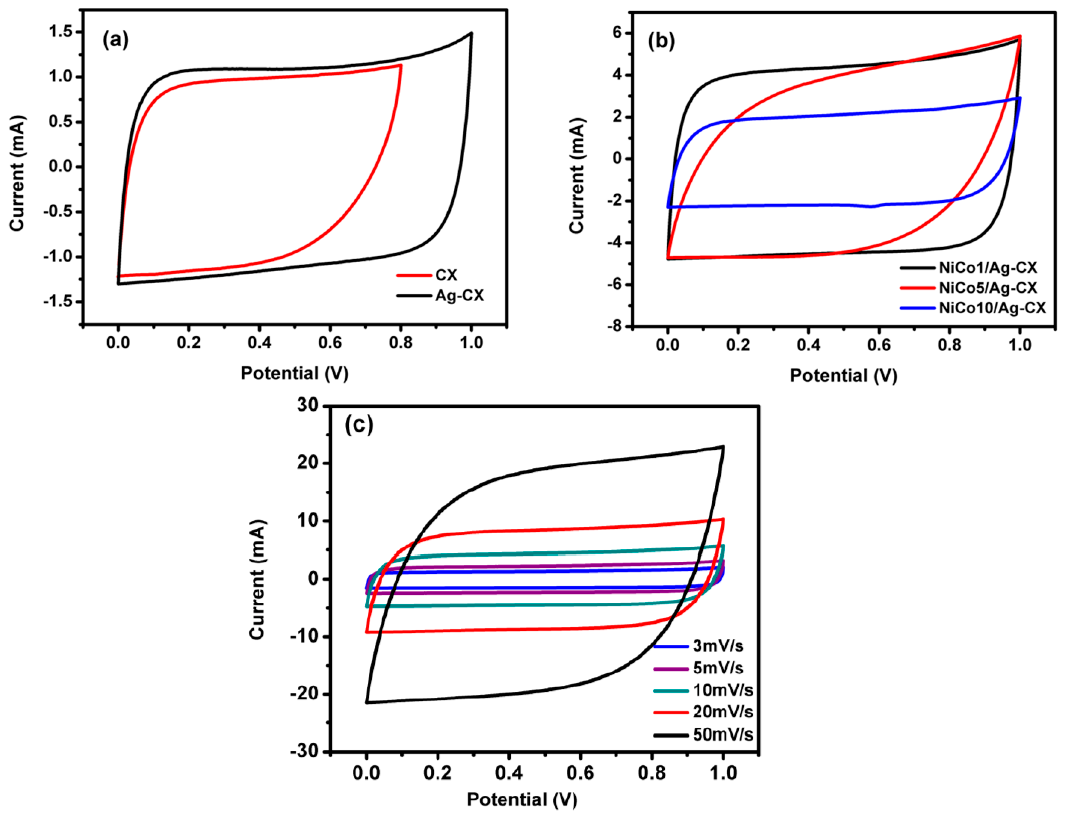
Figure 5. CV curves for ( a ) CX and Ag-CX at 5 mV ∙ s − 1 , ( b ) NiCo1/Ag-CX, NiCo5/Ag-CX, and NiCo10/Ag-CX at 10 mV ∙ s − 1 , and ( c ) NiCo1/Ag-CX at different scan rates.